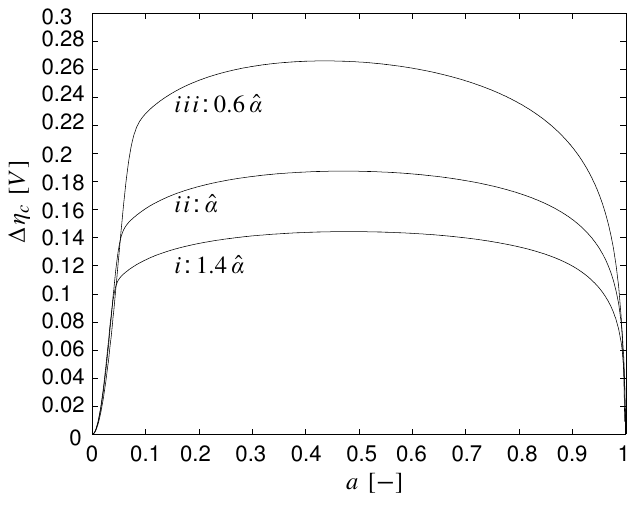
of the overpotential with respect to the c